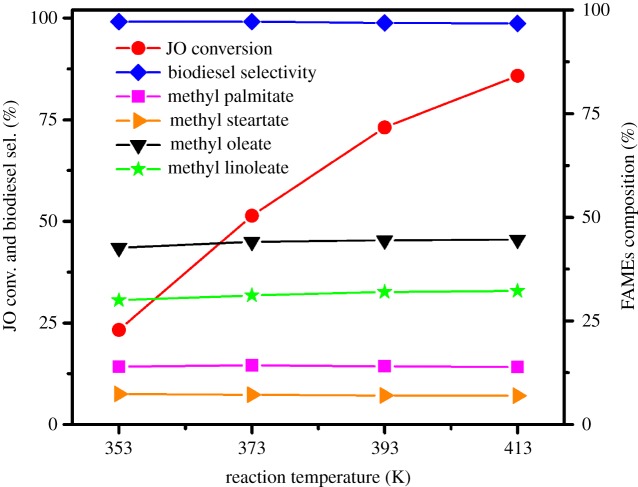
Effect of the reaction temperature on transesterification of JO. Reaction conditions: JO 3.0 g, methanol 1.0 g, petroleum ether 1.0 g, 1.5SO42−/TiO2 catalyst 0.12 g, 24 h, stirring rate 600 r.p.m.